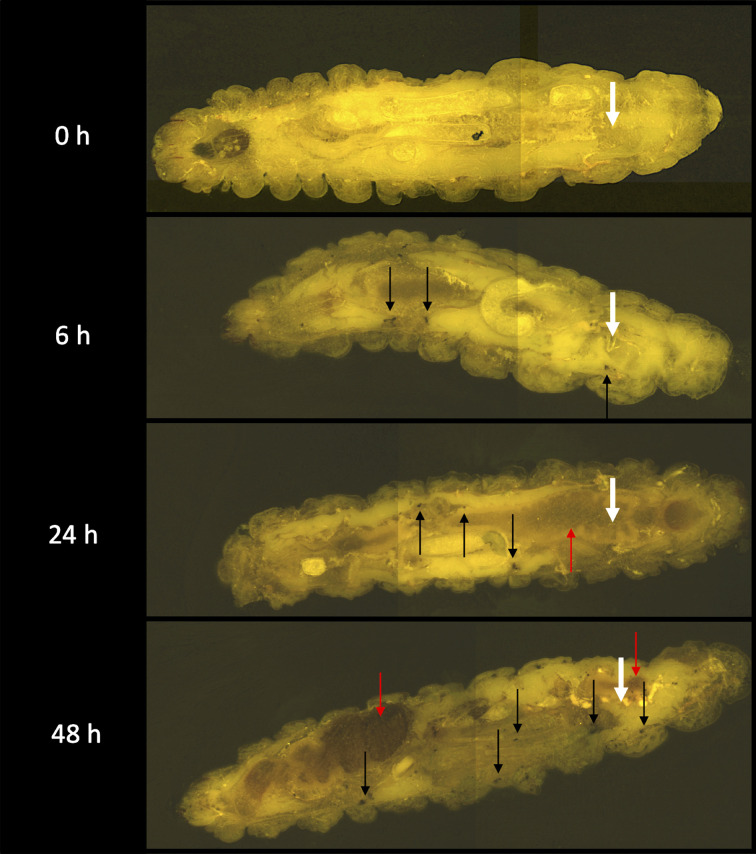
CryoViz-imaging of G. mellonella larvae co-infected with C. albicans and 
S. aureus
. Larvae (n=3) were co-infected with C. albicans (1×105 larva−1) and 
S. aureus
 (2×104 larva−1) for 0, 6, 24 and 48 h at 37 °C. Larvae were embedded, sectioned (10 µm) and visualized using a Cryoviz (Bioinvision, Inc., Cleveland, OH, USA) cryo-imaging system. Point of inoculation, white arrows; nodules, black arrows; extensive melanization, red arrows.